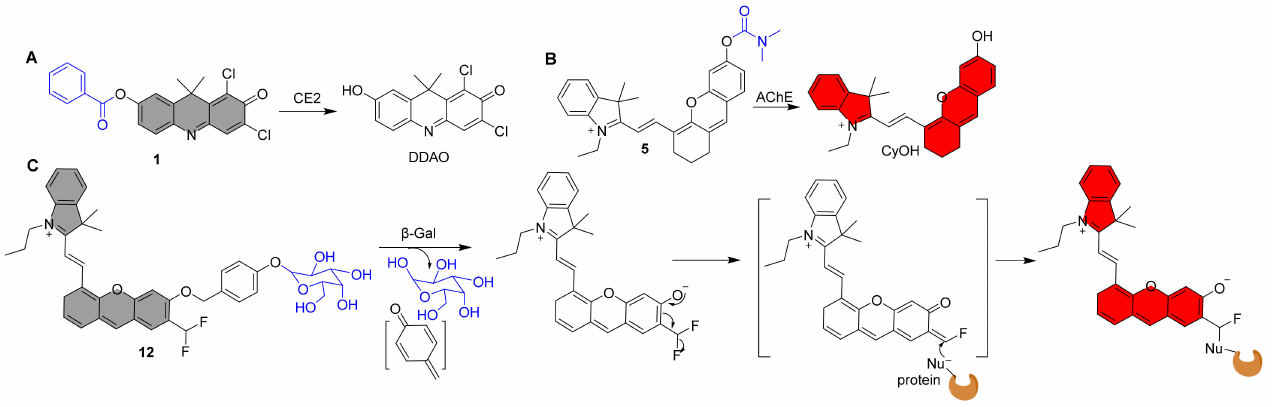
Figure 2. Recognition mechanism of probe 1 , 5 , and 12